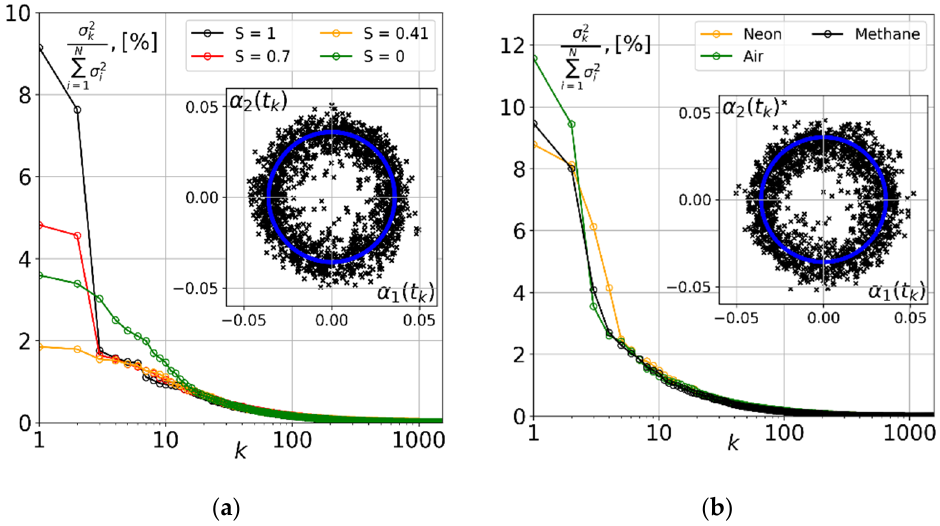
Figure 4. POD spectra and temporal coefficients for the first two POD modes (inset): ( a ) turbulent swirling jets and ( b ) model gas turbine combustor.